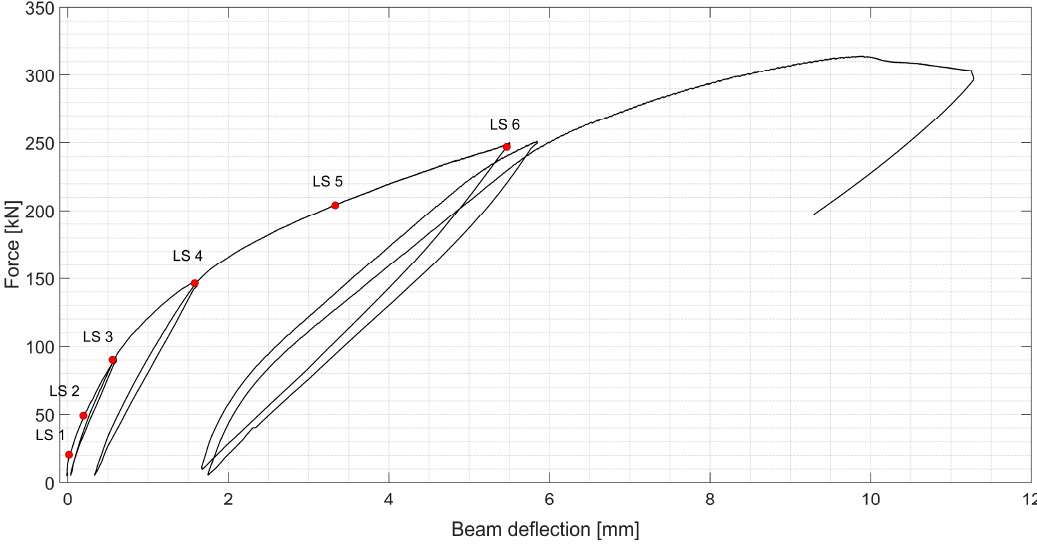
Figure 7. Load–deflection curve of the R-UHPFRC beam during quasi-static test, total jack force presented with consecutive load steps (LS) marked.